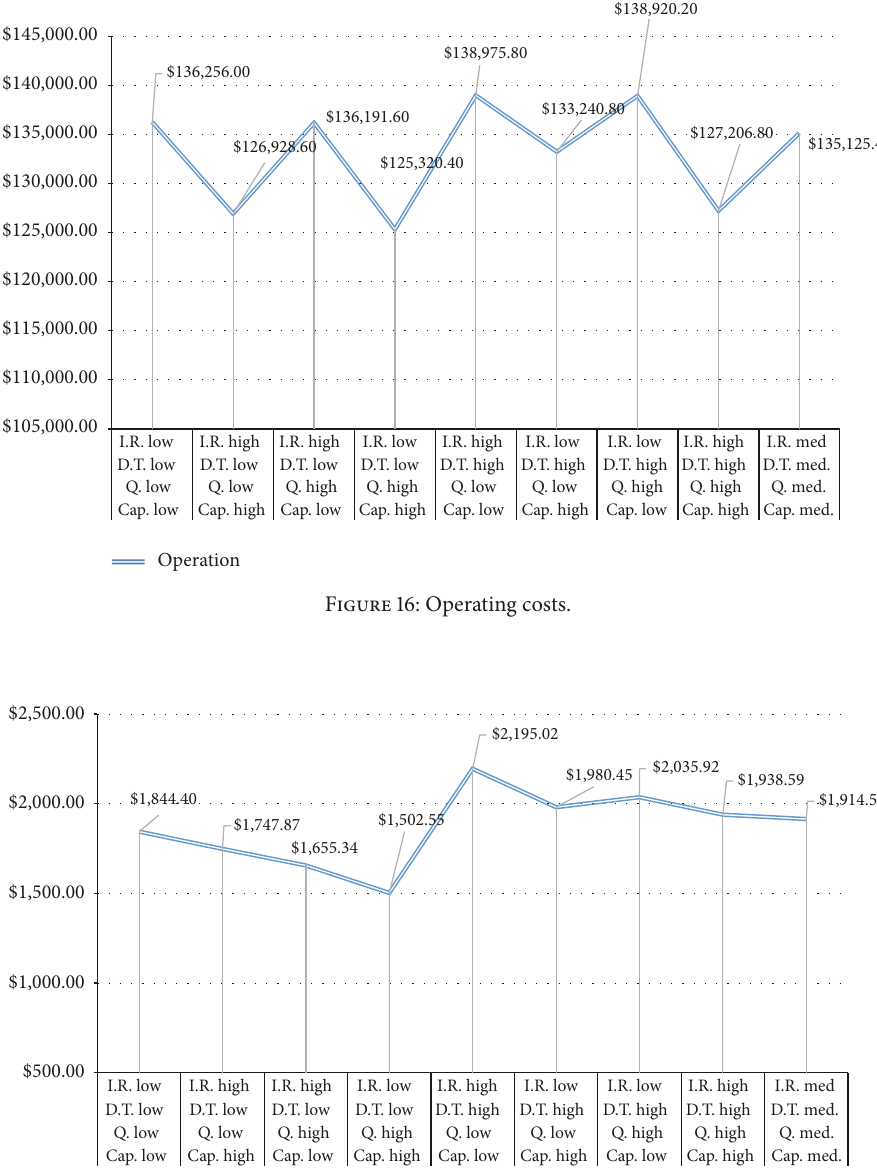
Figure 17: Interest rate (financial)